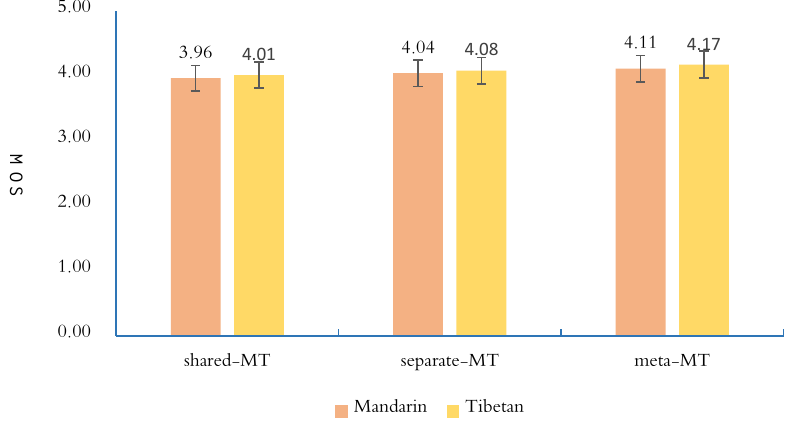
Figure 7. The average MOS scores of synthesized bilingual speech samples in Mandarin speaker’s or Tibetan speaker’s voices under 95% confidence intervals.